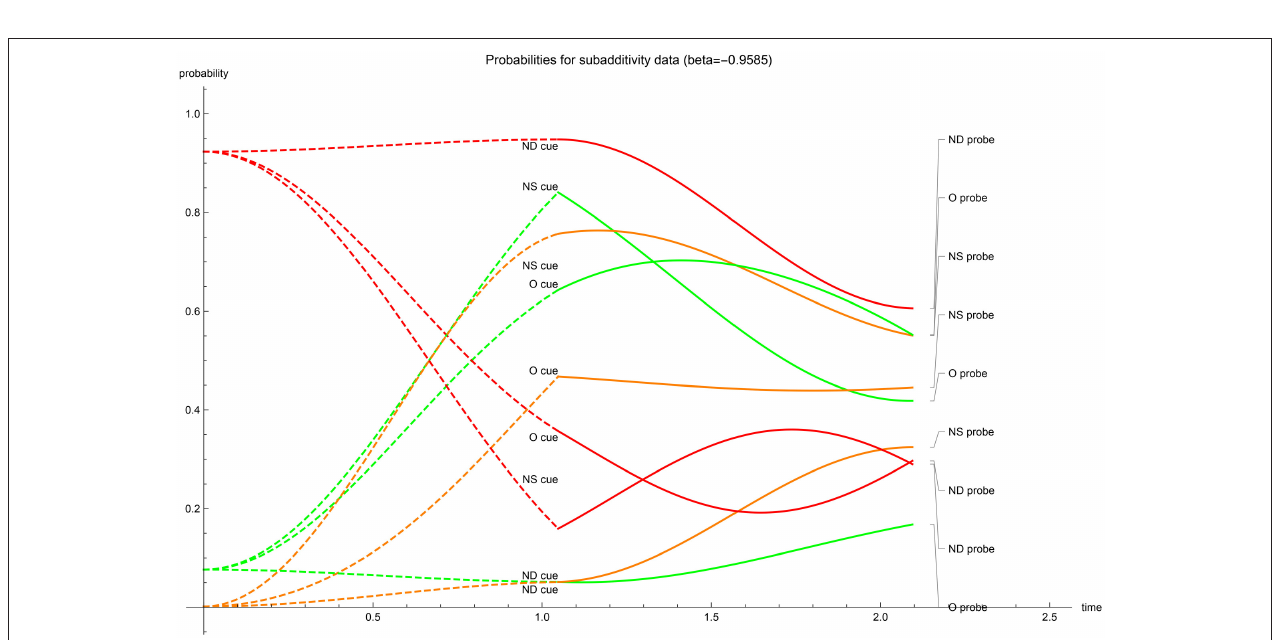
FIGURE 3 | β > 0 case: temporal evolution of acceptance probabilities for the EOD-subadditivity paradigm [1]. Red indicates N probability component, orange indicates G probability component while green indicates V + G probability component. Notice the near absence of verbatim in the initial state.